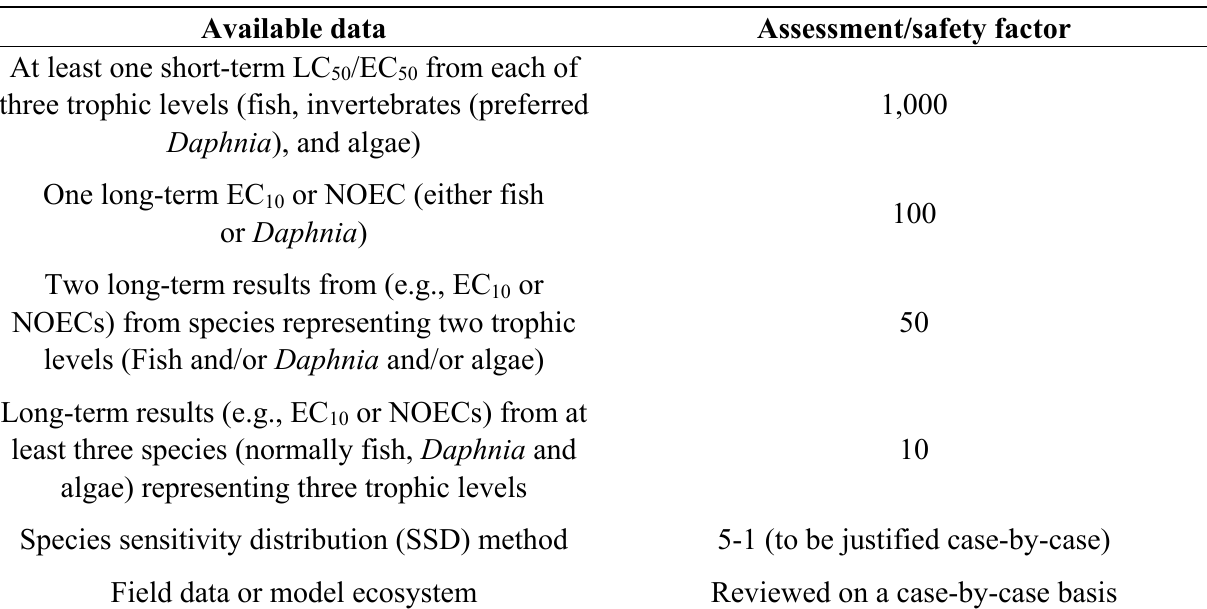
Table 1. Assessment or safety factors for the derivation of environmental quality standards from toxicity data